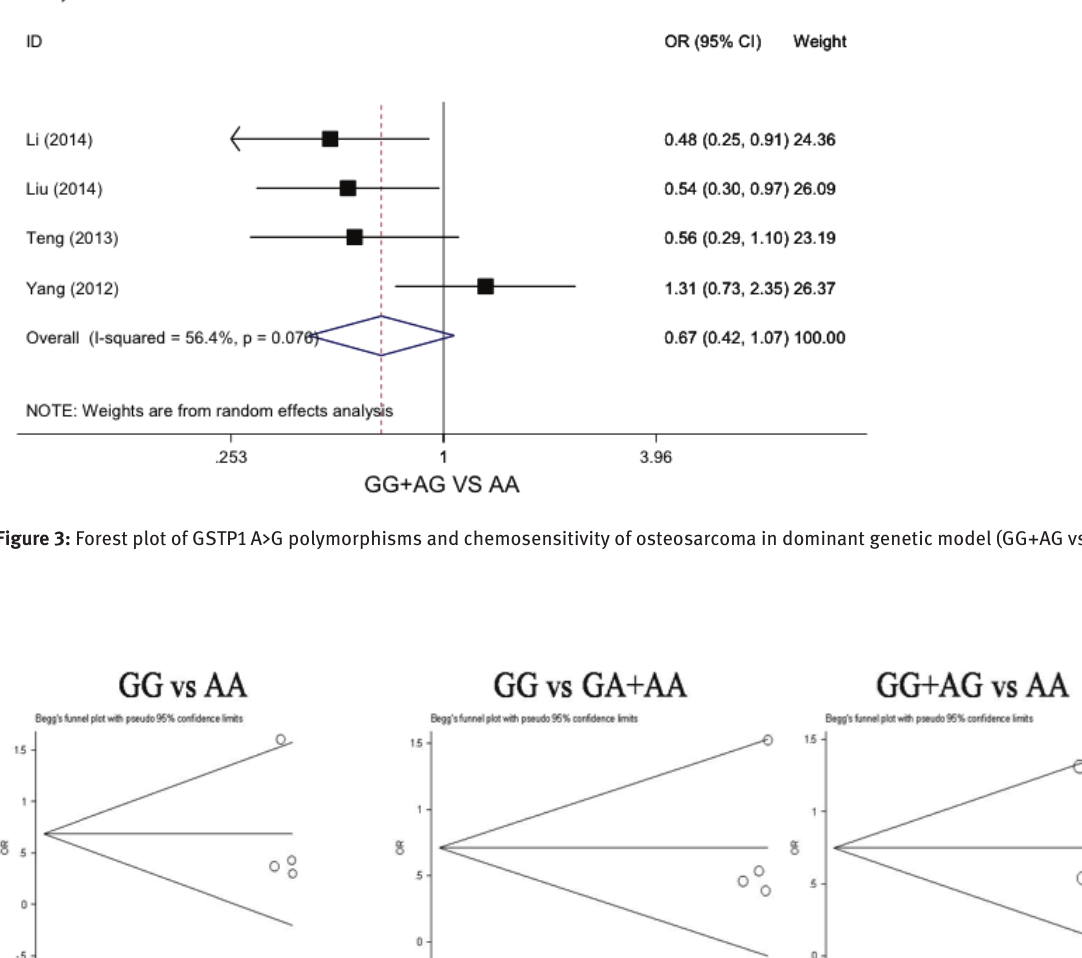
It was indicated that the polymorphisms of GSTP1 was